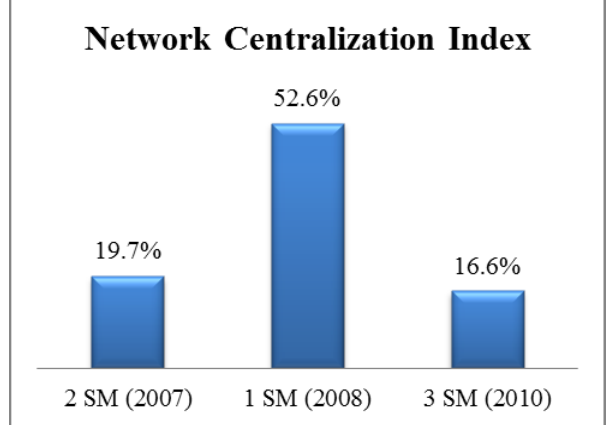
Figure 4. Network centralization index of 1, 2, and 3 SM